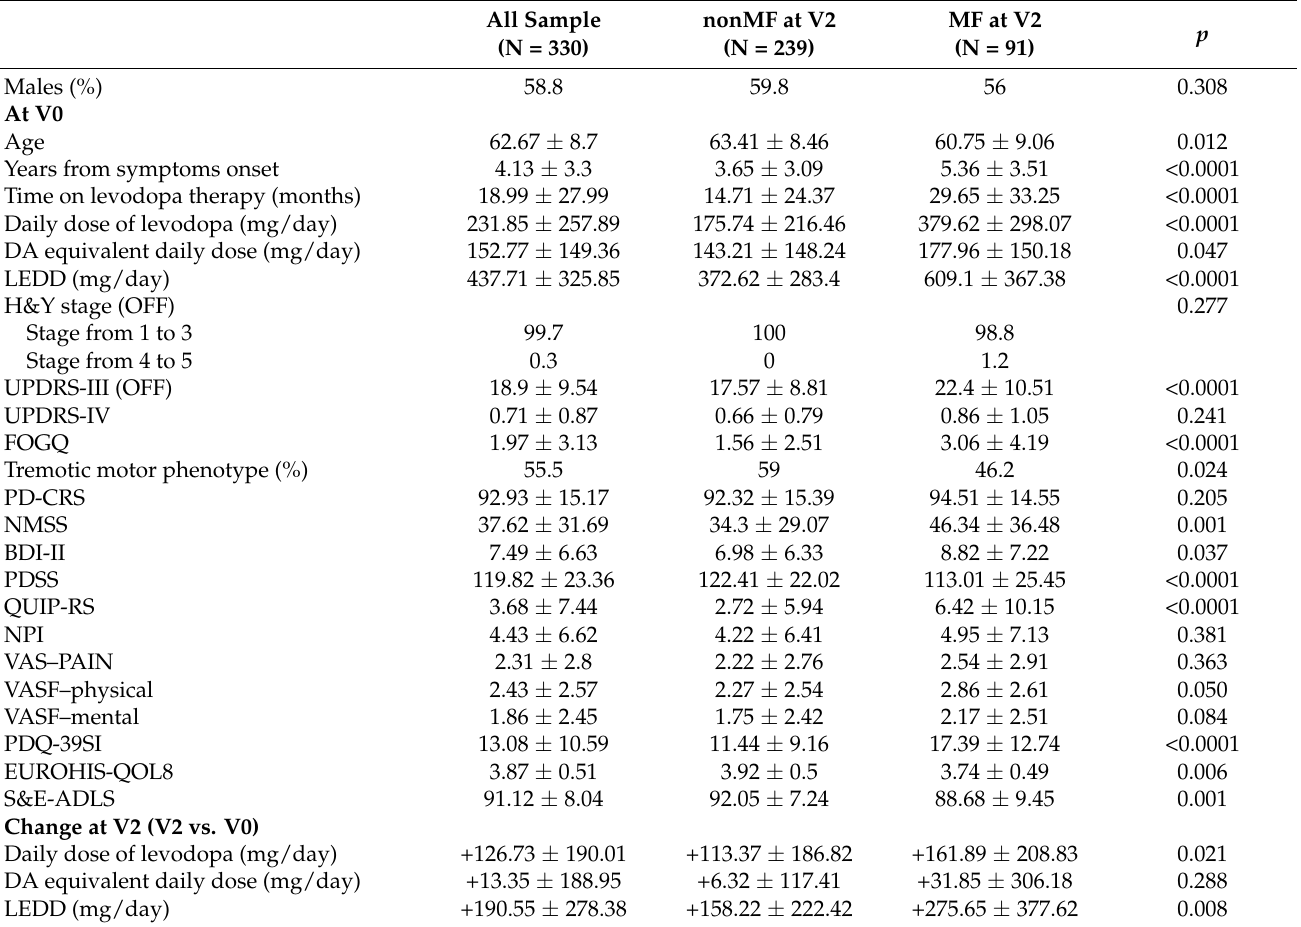
Table 1. Different PD-related variables in PD patients who developed MF at V2 (MF at V2; N = 91) compared with those patients who did not develop MF at V2 (nonMF at V2; N = 239). All